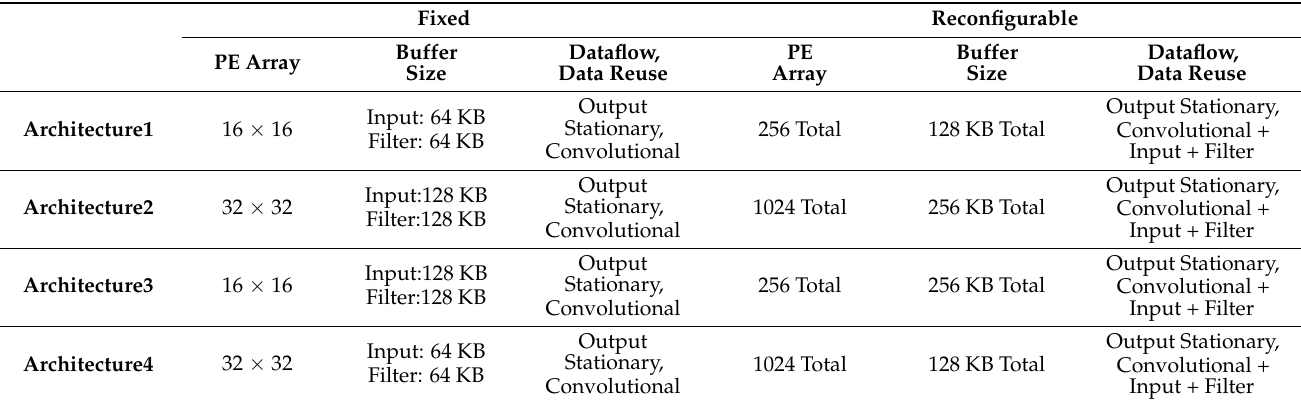
Table 1. Target architecture configurations.